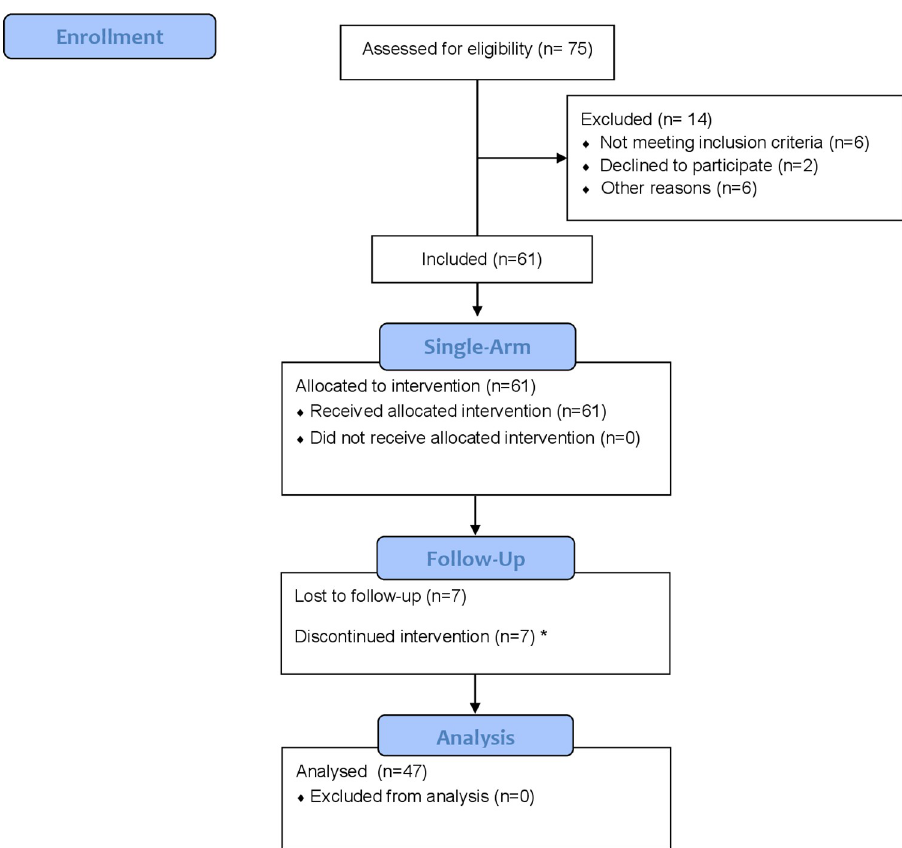
Fig 1. Screening to week 48. NOTE. ( � ) hyperamylasemia related to a prior history of alcohol abuse. (#) false-positive HIV test. LTFU, lost to follow-up. SAEs: suicide attempt (1) and death